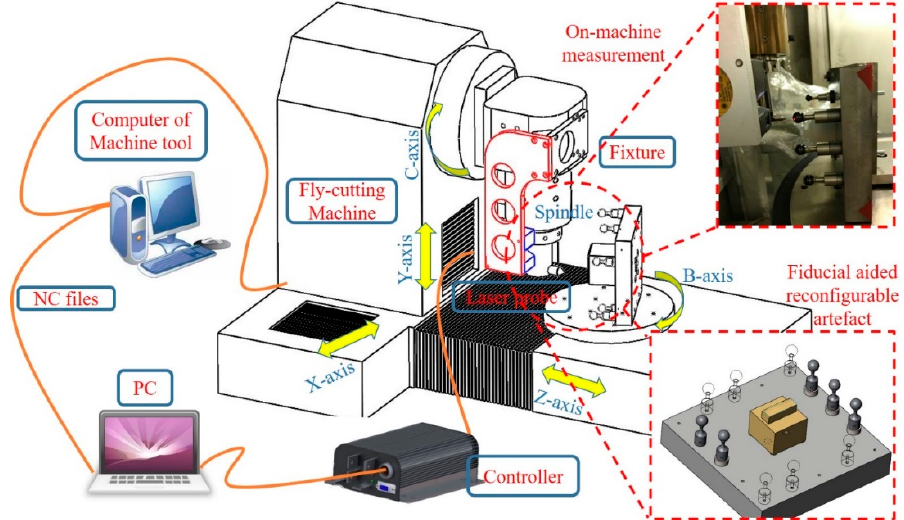
Figure 1. A schematic diagram of the fiducial-aided reconfigurable artefact mounted on the B-axis of a five-axis ultra-precision machine tool.